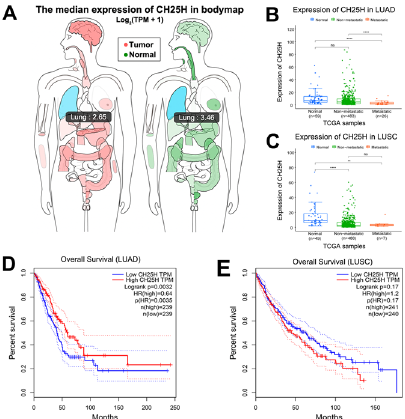
Figure 1. CH25H expression level analysis using public database. ( A ) The bodymap displayed the mRNA expression of CH25H in lung tumor and paired normal tissues (GEPIA); ( B , C ) the CH25H expression levels in normal and tumor with non-metastatic and metastatic tissues (UALCAN). ( D , E ) the prognostic value of CH25H expression in LUAD and LUSC patients (TIMER). “**”, “***” and “ns” indicate p < 0.01, p < 0.001 and p > 0.05,